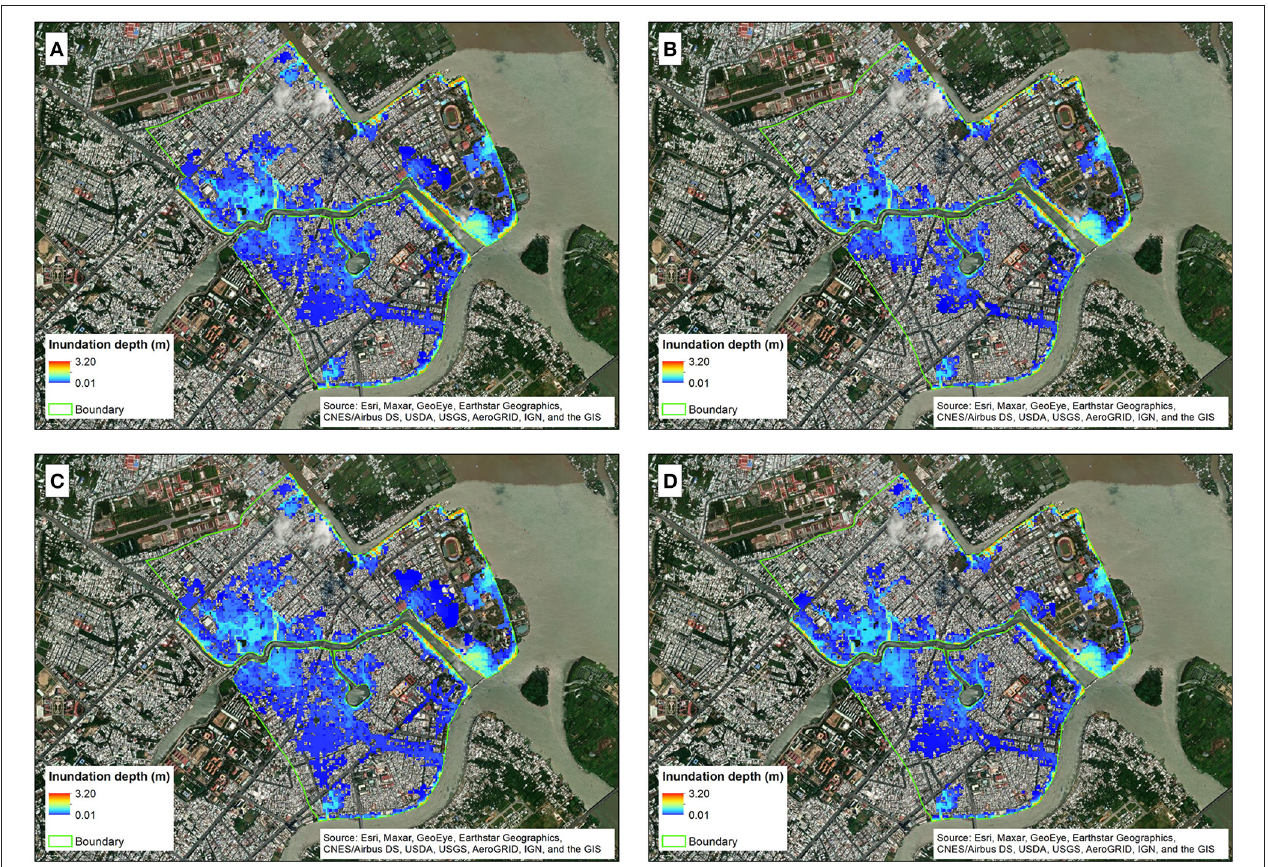
FIGURE 10 | Flood hazard maps (i.e., maximum flood depths) for the 100-year return period of water level for hydrograph shape Pattern 1 (left) and Pattern 2 (right) under RCP 4.5 (A,B) and RCP 8.5 (C,D) (without land subsidence). The inundated area (for cells with maximum inundation depths ≥ 0.02m) for RCP 4.5 and RCP 8.5 corresponding to Pattern 1 are 1.96 and 2.30 km 2 , respectively, while for Pattern 2 are 1.41 and 1.81 km 2 , respectively.